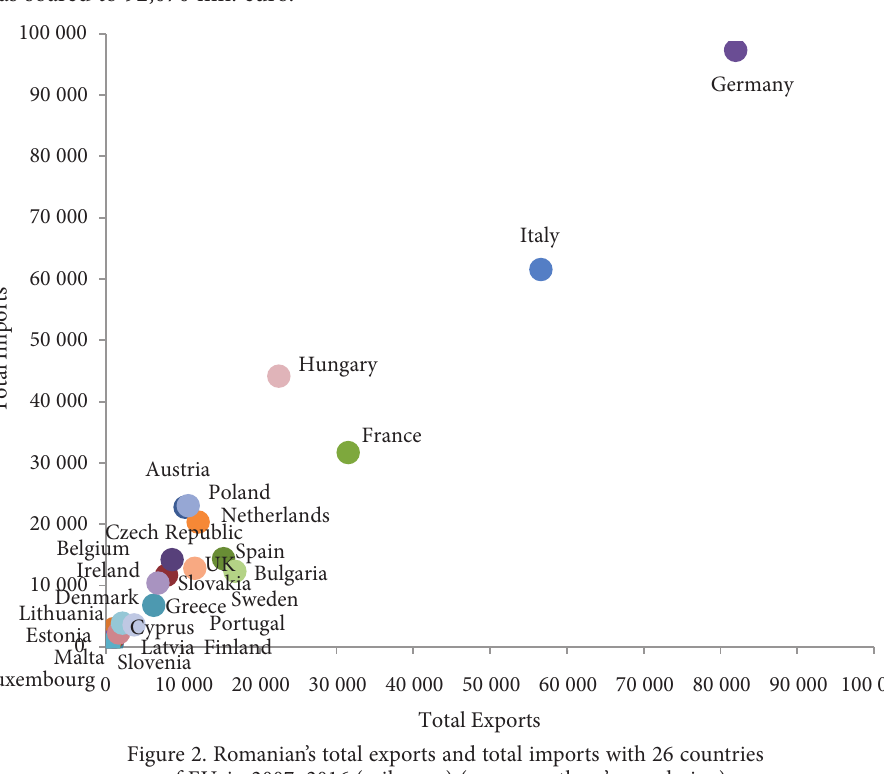
Figure 2. Romanian’s total exports and total imports with 26 countries of EU, in 2007–2016 (mil. euro) (source: authors’ own design) A similar geographic concentration appears, over the same reference time, in the total worth of the import-export flows for livestock and animal products, vegetable products, vegetable or animal fats and oils. The levels of concentration of total exports and total imports of livestock and animal products, vegetable products, vegetable or animal fats and oils of Romania in the EU, in aggregate values over the period 2007–2016, are also high. The values of Gini Coefficient (0.305 for T_E_LAVFO and 0.3429 for T_I_LAVFO), and the Lorentz Curves (Figure 3) dem- onstrate that in this case the level of concentration of the import flows T_I_LAVFO is higher than the level of concentration of the export flows (T_E_LAVFO). This reveals that some 10% of the states considered for this analysis account for 50% of Romania’s import flows for livestock and animal products, vegetable products, vegetable or animal fats and oils, while the export flows are covered by 10% of the states, which cover some 40% of total